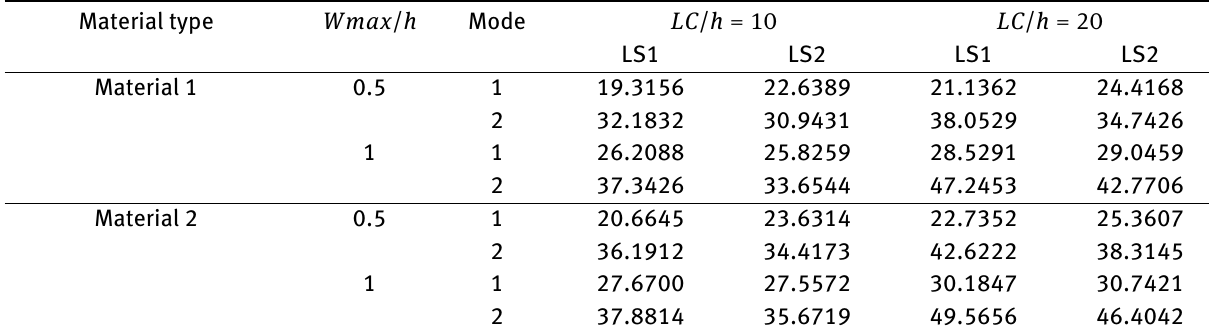
Table 8: Effect of material property, amplitude ratio, frequency mode, curvature to thickness ratio and lamination scheme on dimensionless mean nonlinear natural frequency of conical shell panel (LS1 and LS2 indicate [P/0 ∘ /45 ∘ /0 ∘ /45 ∘ ] and [0 ∘ /P/45 ∘ /0 ∘ /45 ∘ ], respectively).